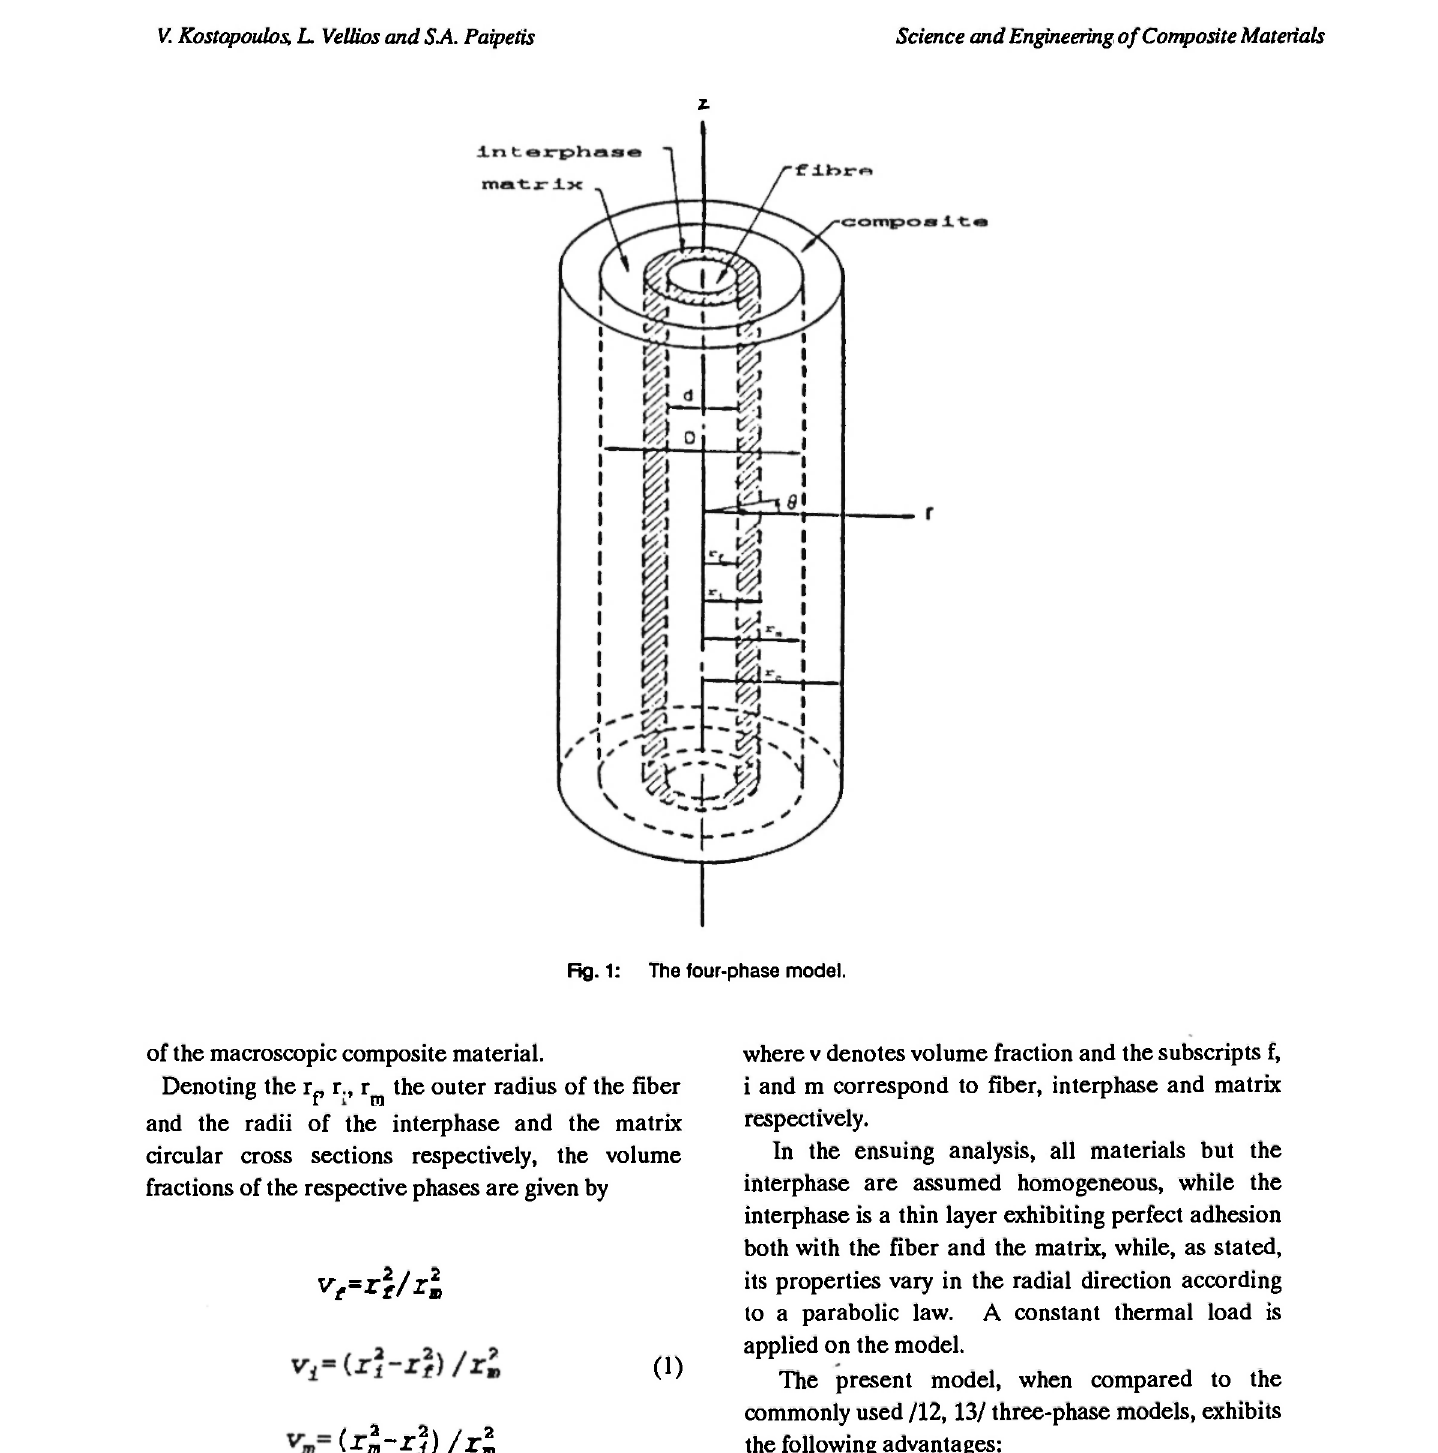
Fig. 1: The four-phase